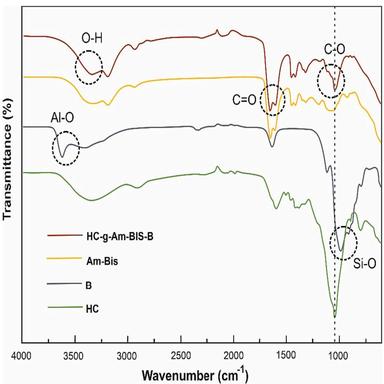
FT-IR spectra of hemicelluloses (HC), hydrogels (HC-g-Am-BIS-BT), Am-BIS and bentonite (BT).